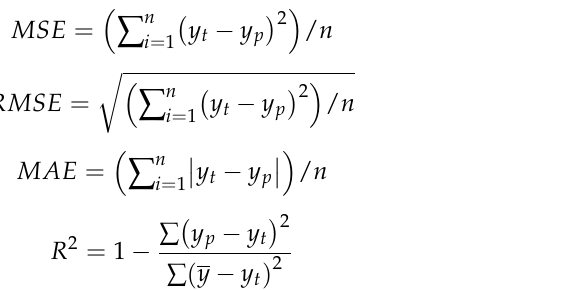
sample, respectively, and n is the corresponding sample